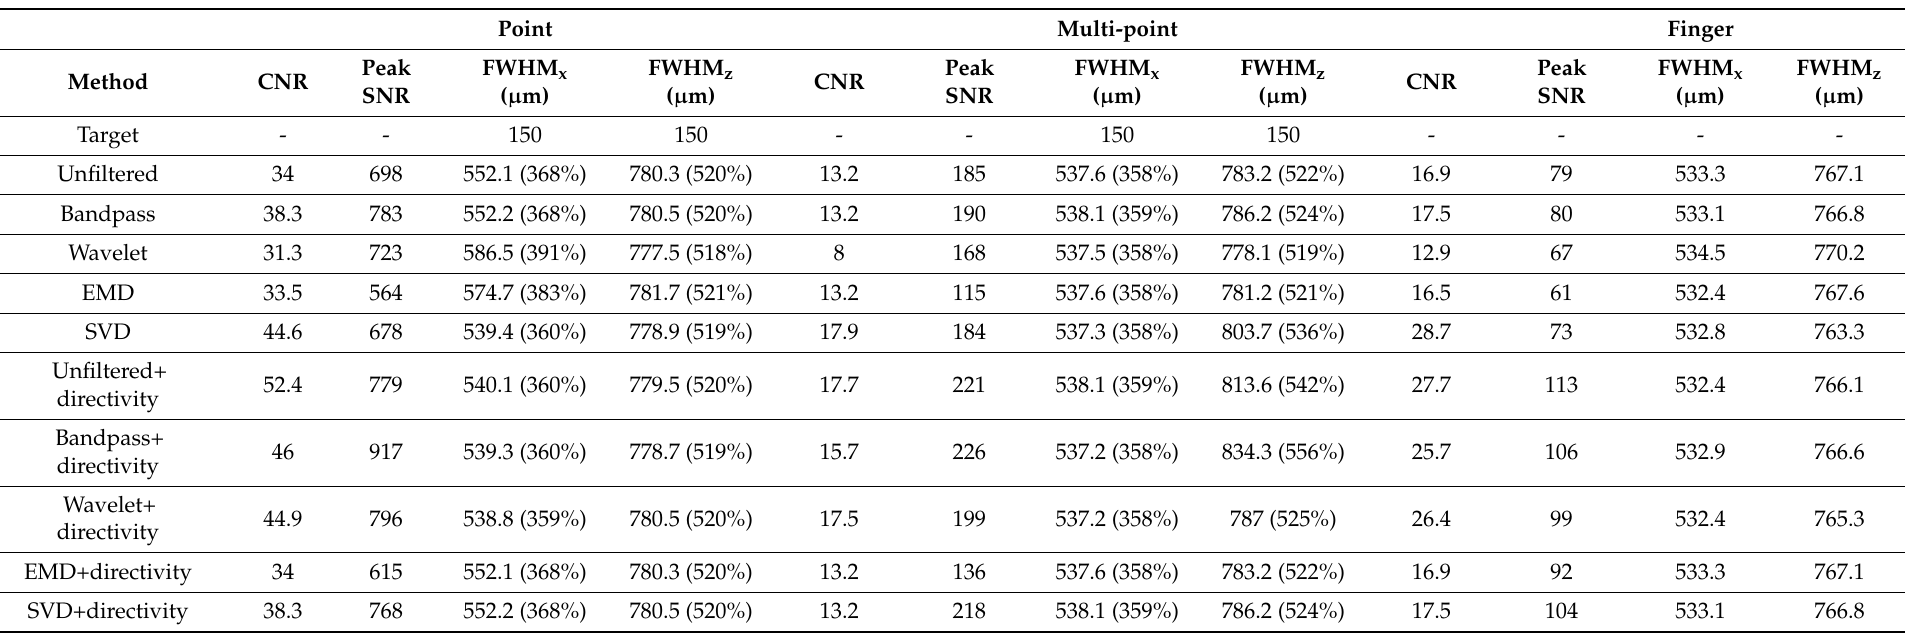
Table 2. Noise reduction (CNR, higher means better), peak SNR (higher means better) and resolution (FWHM, lower means better) compared between preprocessing methods. Comparisons with the actual imaging phantom are listed in the brackets under the FWHM